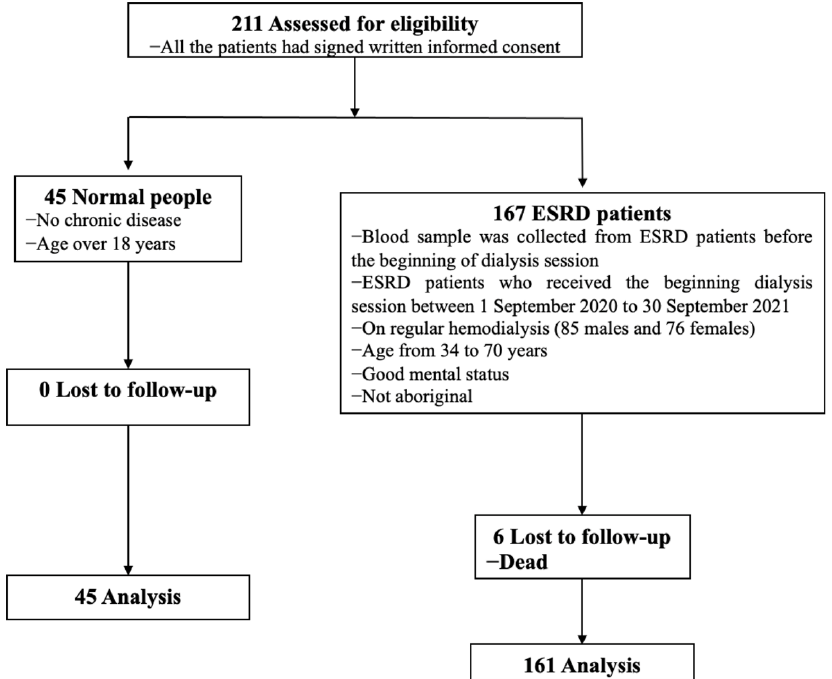
Figure 1. The enrollment flow chart of this study. A total of 211 participants, including 167 ESRD patients receiving regular hemodialysis at Jen-Ai Hospital or Xinren Clinic Hospital, and 45 healthy adults was enrolled. The Ethics Committee of the Clinical Center of Jen-Ai Hospital approved the study, and all the patients signed written informed